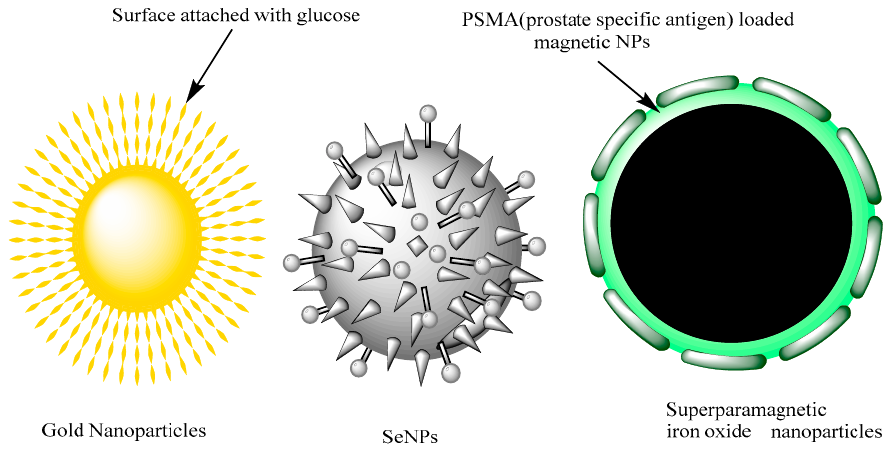
Figure 2. Glucose capped gold nanoaprticles and SeNPs and Superparamagnetic iron oxide nanoparticles for treatment of PCa. Reproduced from [79] with permission from DeGruyter,